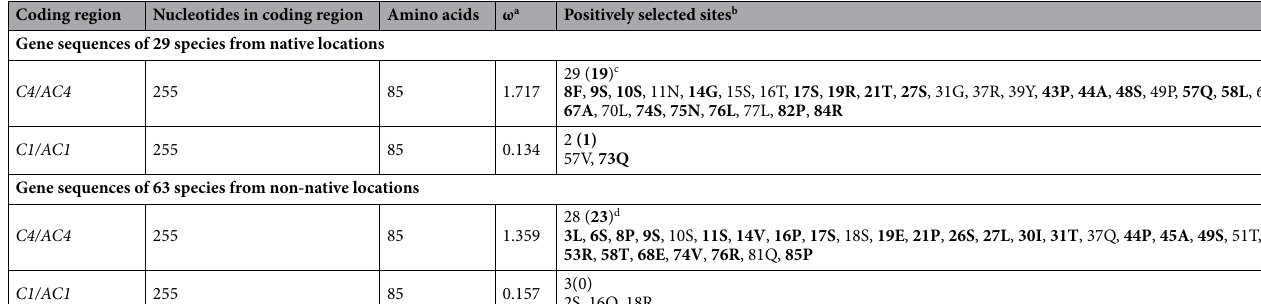
Table 3. Positive selection analyses of C4(AC4 ) or C1(AC1) gene sequences from begomovirus species isolated from Solanum lycopersicum from native and non-native locations. a Mean ratio of the nonsynonymous ( d N ) and the synonymous substitution rates ( d S ). ω < 1 represents purifying selection; ω = 1 neutral selection; and ω > 1 positive selection. b Number of amino acid sites under positive selection base on Bayes empirical Bayes analysis 47 . Amino acid residue number and single letter amino acid designation having a posterior probability of P > 90% in regular font and of P ≥ 95% in bold font. c Amino acid positions and amino acids refer to AF101476 (Chino del tomate virus; CdTV). d Amino acid positions and amino acids refer to JN135234 (Pepper leaf curl Lahore virus;